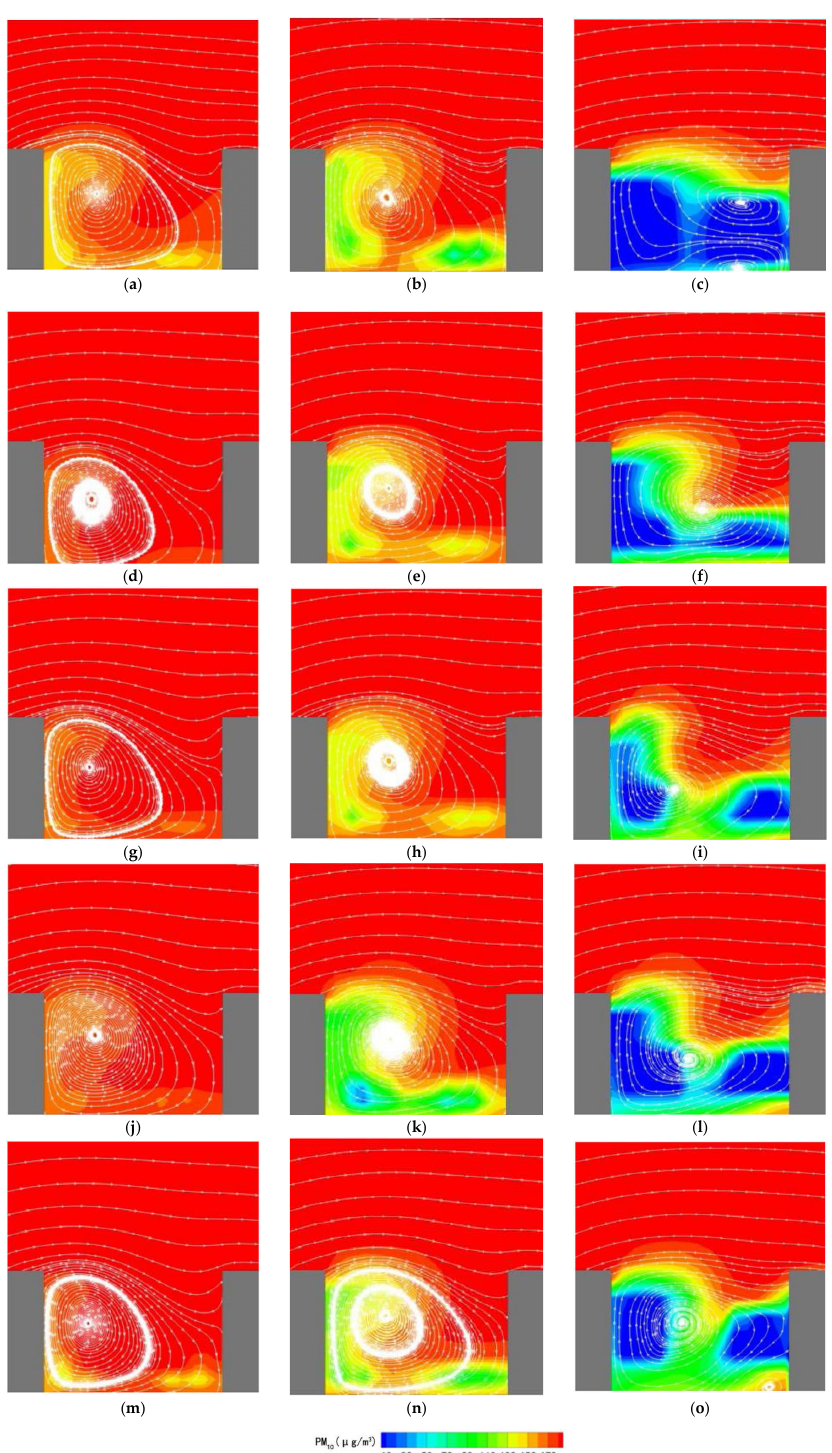
Figure 3. Streamlines and PM10 concentration contours on the vertical plane near the canyon center among five tree species and three growth periods for 5 years (left panel), 10 years (middle panel), and 30 years (right panel) when H/W = 0.9 [73]. ( a ) 5 years G. biloba . ( b ) 10 years G. biloba . ( c ) 15 years G. biloba . ( d ) 5 years A. chinense . ( e ) 10 years A. chinense . ( f ) 15 years A. chinense . ( g ) 5 years A. buergerianum . ( h ) 10 years A. buergerianum . ( i ) 15 years A. buergerianum . ( j ) 5 years L. chinense . ( k ) 10 years L. chinense . ( l ) 15 years L. chinense. ( m ) 5 years C. deodara . ( n ) 10 years C. deodara . ( o ) 15 years C. deodara .